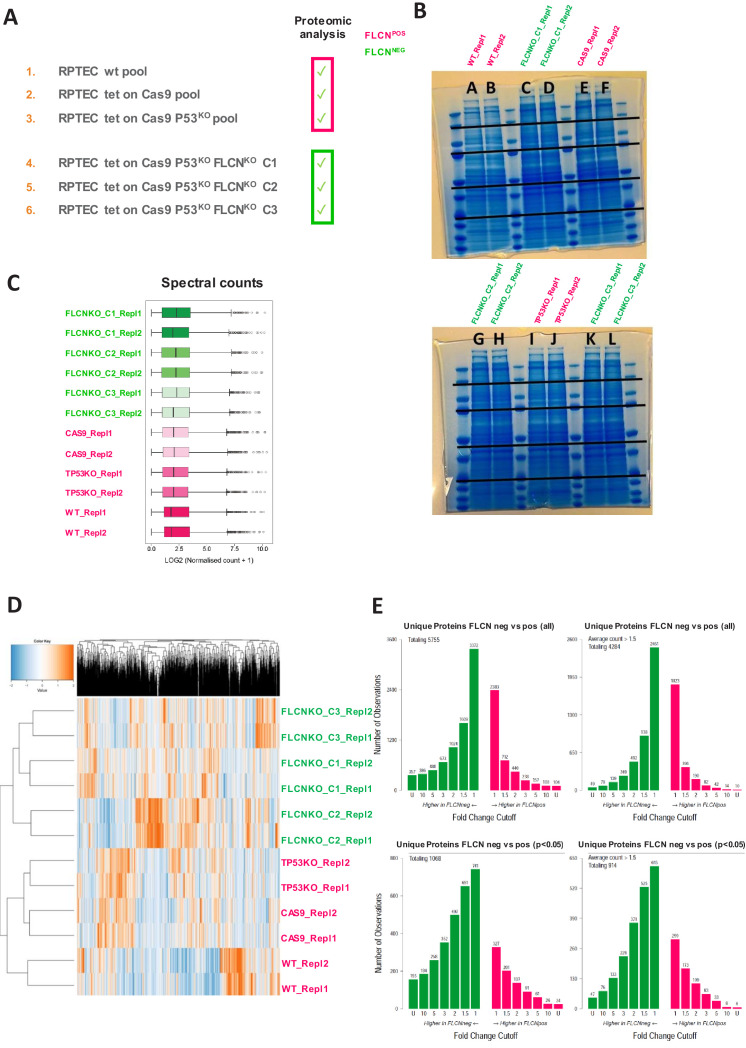
GeLC-MS/MS-based proteomics of RPTEC FLCNPOS vs. FLCNNEG cell line pairs.(A) Cell lines used as input lysates for proteomic analyses FLCNPOS vs. FLCNNEG RPTECs. (B) Coomassie staining of gel containing samples for proteomic analyses, 5-band fractionation, two technical replicates per cell line were measured. (C) Overview of the normalized spectral counts per cell line. (D) Unsupervised hierarchical clustering of all proteins identified in MS experiment (normalized counts). (E) Numbers of all (top plots) or p<0.05 (lower plots) differential proteins observed in FLCNNEG or FLCNPOS RPTECs, ranked by fold change. Left: no threshold counts; right: average count >1,5. The data show upregulated protein expression by FLCN loss. Statistical details can be found in Materials and methods section.